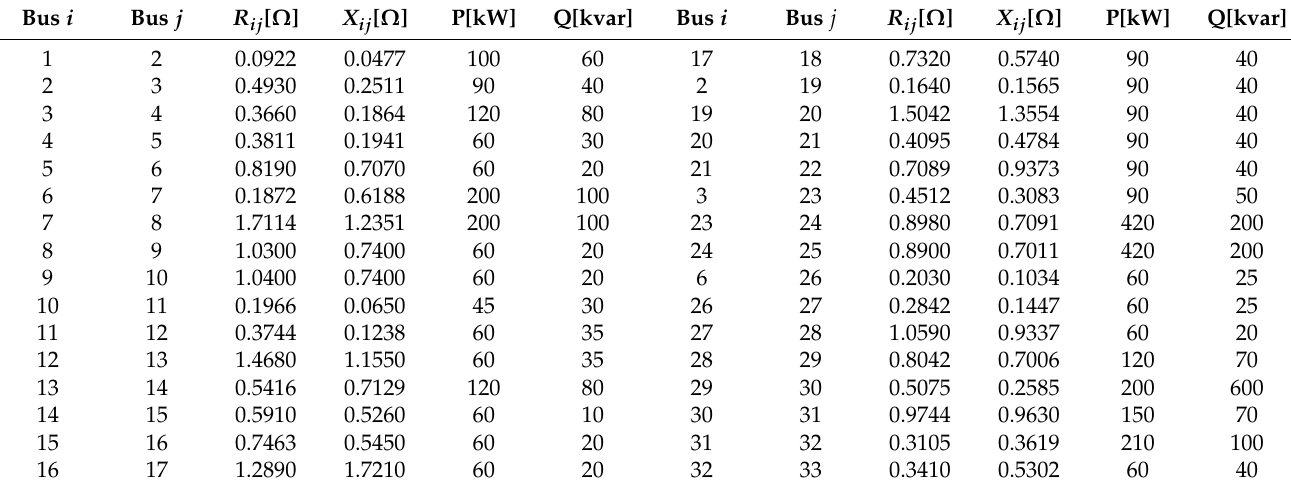
Table 2. Parameters of the 33-bus test